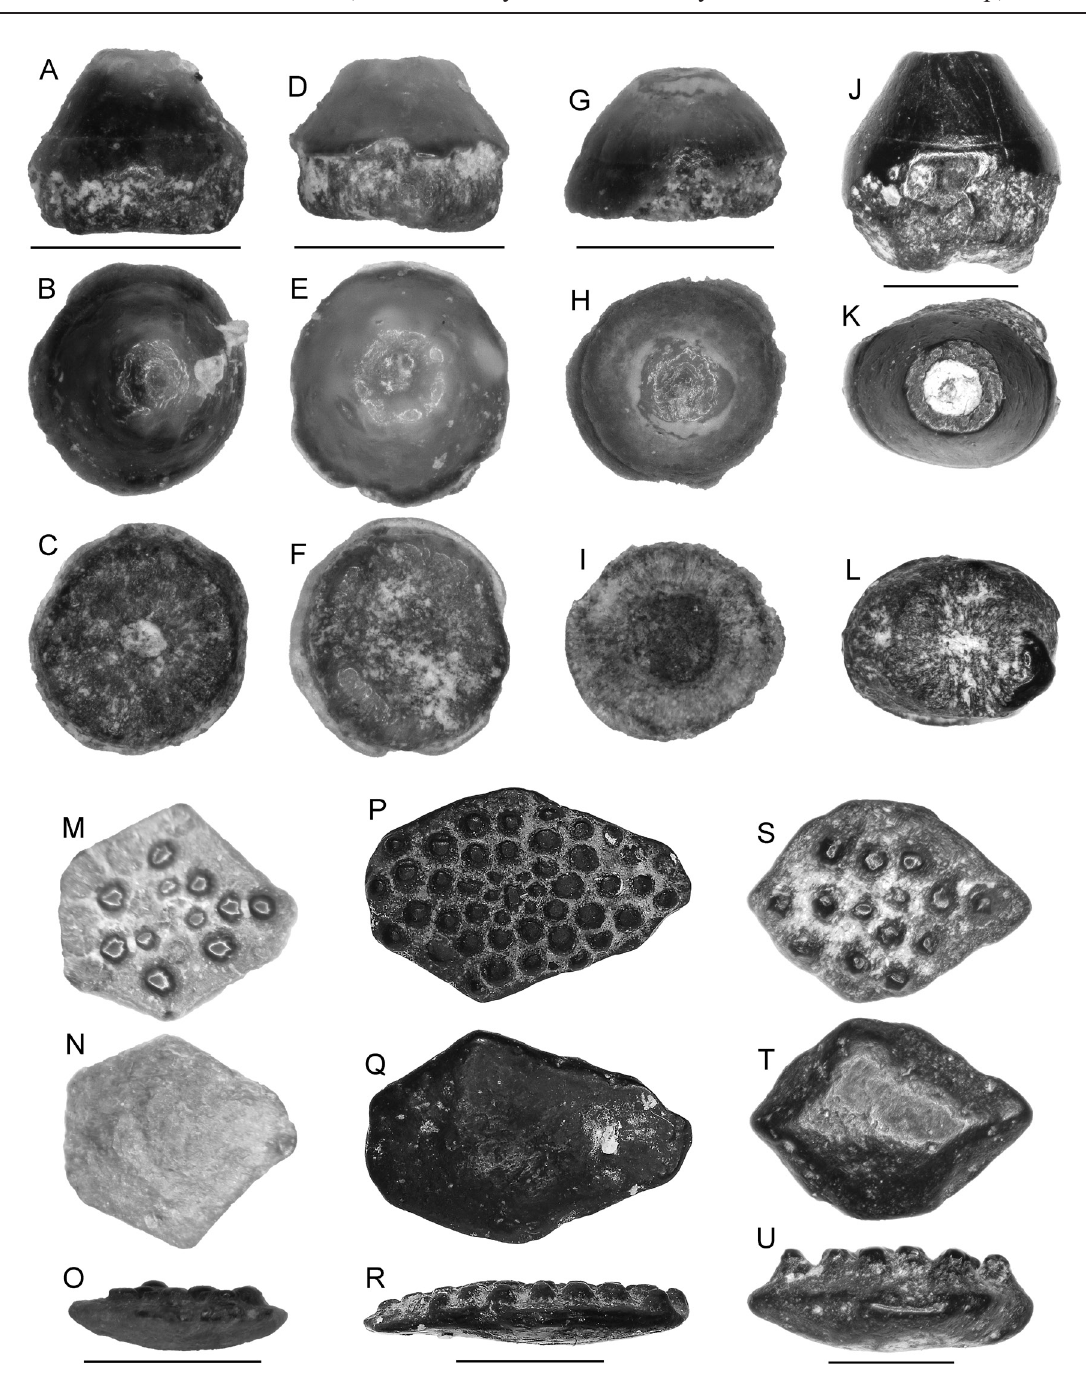
Fig. 66. Fisherichthys aff. F. folmeri Weems, 1999 and Ostraciidae Rafinesque, 1810,